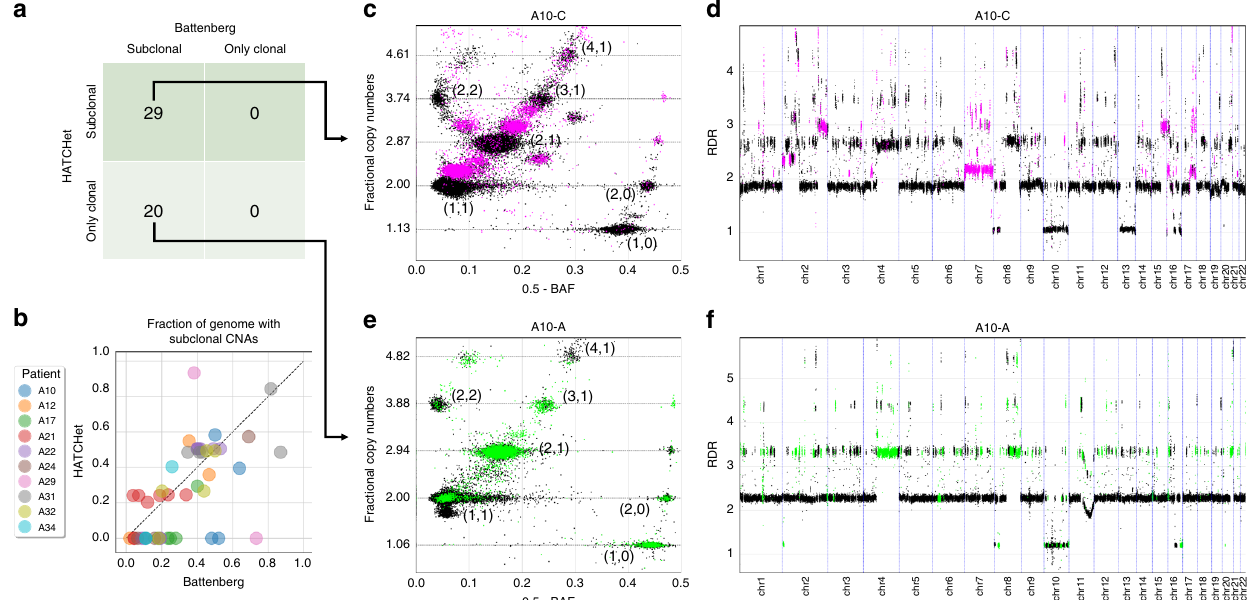
Fig. 3 HATCHet identi fi es moderate amount of subclonal CNAs in prostate cancer patients. a HATCHet identi fi es subclonal CNAs in 29 samples, while Battenberg identi fi es subclonal CNAs in all 49 samples. b In the 29 samples where both methods identify subclonal CNAs, HATCHet and Battenberg infer similar fractions of the genome with subclonal CNAs (dotted diagonal), while in the other 20 samples only Battenberg retrieves relatively high fractions of subclonal CNAs. c In sample A10-C of patient A10, both HATCHet and Battenberg identify reliable subclonal CNAs that correspond to sample-subclonal clusters (magenta) with clearly intermediate positions in the scaled BAF-RDR plot (each point corresponds to 50 kb genomic bin) between those of sample-clonal clusters (black clusters with corresponding copy-number states) with clonal CNAs (dashed black lines). d The sample-subclonal clusters in c correspond to large genomic regions (magenta) with values of RDR (for 50kb genomic bins) clearly distinct from the RDR values of regions from sample- clonal clusters (black). e In sample A10-A of patient A10, Battenberg identi fi es extensive clusters of 50kb genomic bins with subclonal CNAs (green). However, such clusters are not clearly distinguished in the scaled BAF-RDR plot from the sample-clonal clusters (black with corresponding copy-number states). HATCHet infers only clonal CNAs in this sample. f The sample-subclonal clusters in e correspond to large genomic regions (green) with values of RDR (for 50kb genomic bins) approximately equal to the RDR values of nearby regions from sample-clonal clusters